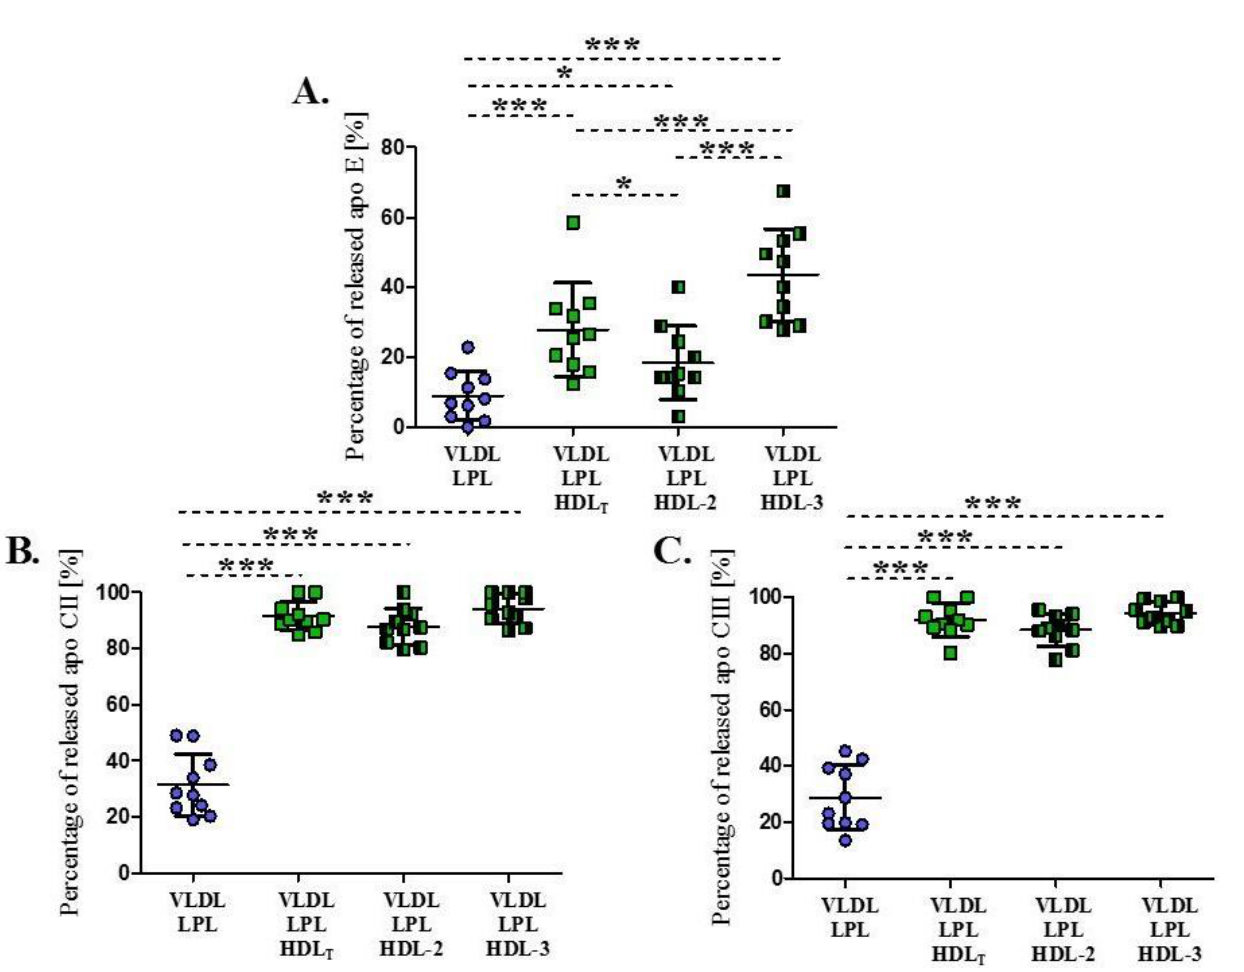
Figure 3. Percentage of apo E ( A ), apo CII ( B ) and apo CIII ( C ) released from VLDL during LPL-mediated lipolysis in the absence or presence of HDL T and HDL subpopulations: HDL-2 and HDL 3. Data are presented as mean ± SD, n = 10, * p < 0.05; *** p < 0.001. Data were analyzed by Repeated Measures ANOVA with Tukey post hoc.